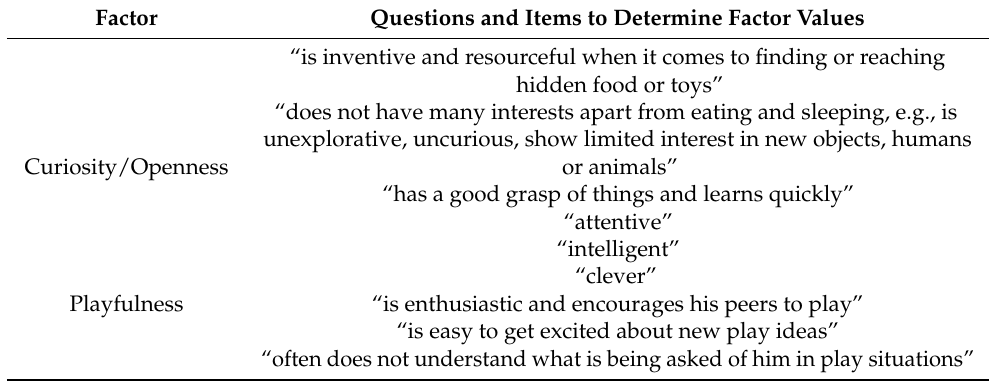
Table 5. Questions and items related to personality factors curiosity and playfulness in